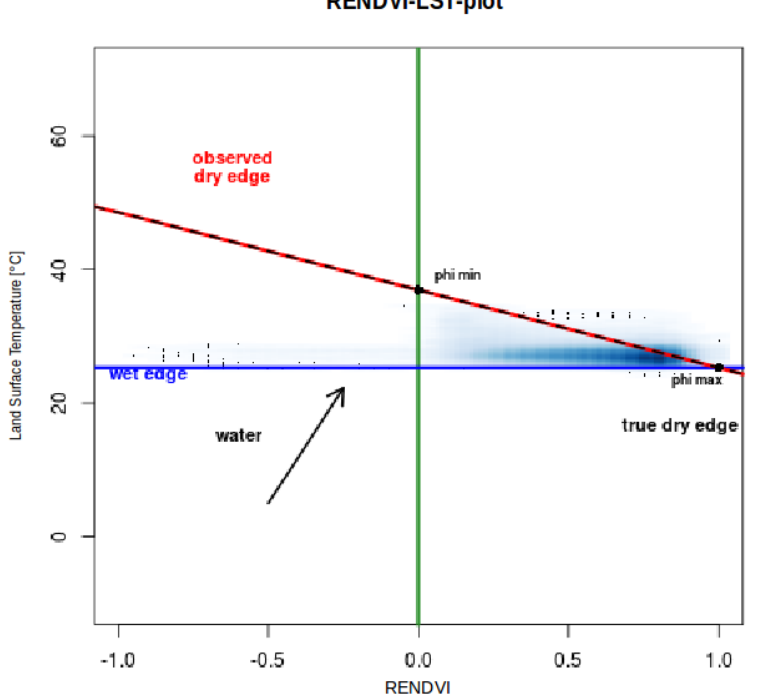
Figure 7. RENDVI-LST triangle plot including dry and wet